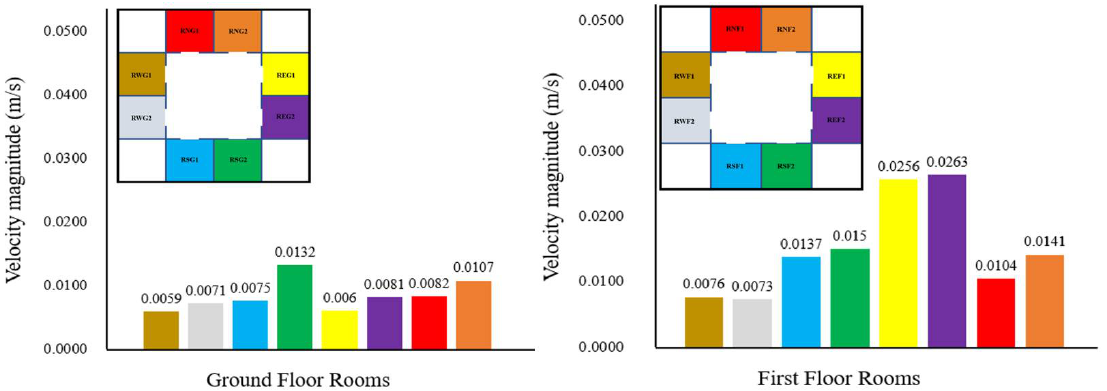
Figure 27. Average wind speed magnitude (m/s) in each room for the baseline courtyard model with four large trees.